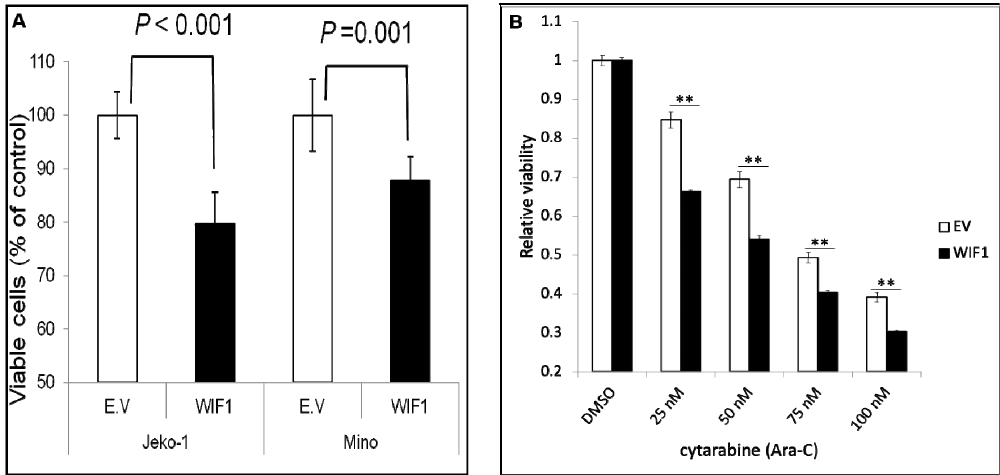
Figure 5. WIF1 inhibits MCL cell growth and sensitizes them to cytarabine (Ara-C). ( A ) Transient gene transfection of WIF1 significantly decreased the number of viable cells. ( B ) The same treatment also significantly increased the inhibitory effect of cytarabine (Ara-C) in JeKo-1 cells. MTS assay was used to assess the number of viable cells. ** p value <